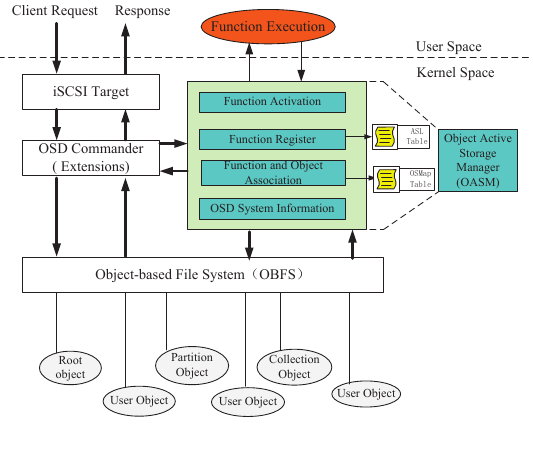
Fig. 2. Oasa architecture